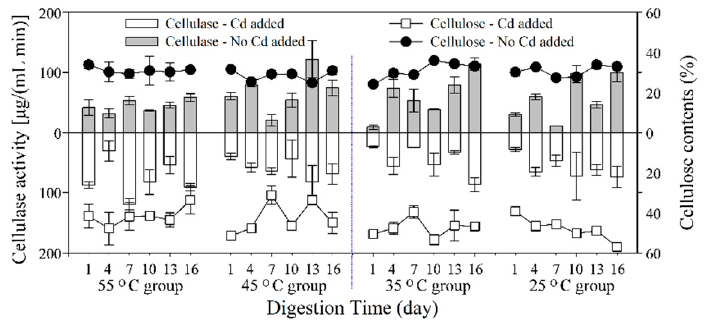
Figure 6. Cellulase activity of the no Cd-added group and Cd-added group with digestion temperatures of 55 °C, 45 °C, 35 °C, and 25 °C.